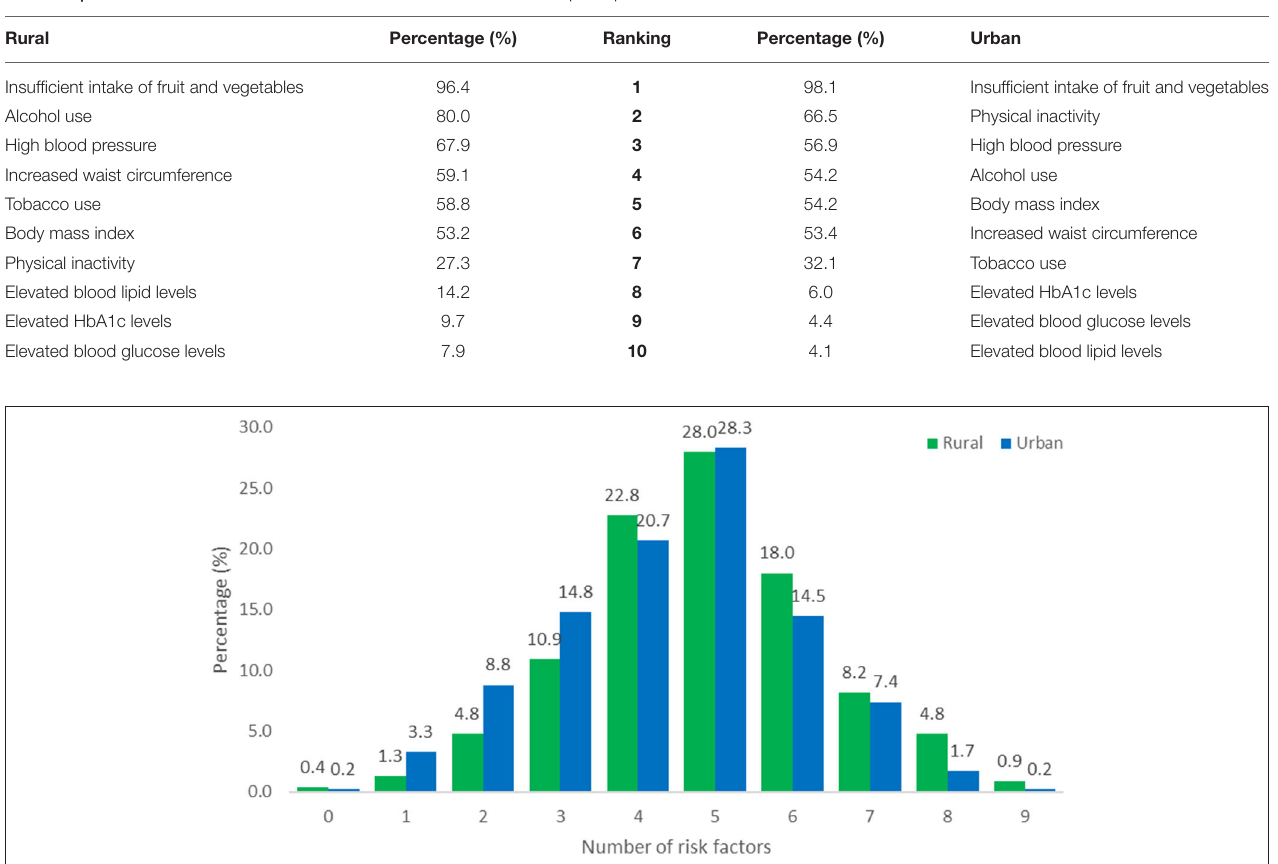
TABLE 3 | Ranked behavioral and metabolic risk factors of rural and urban participants.